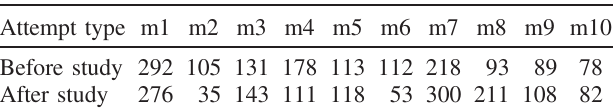
TABLE VIII. Mean log duration of before and after study attempts for each module, in units of